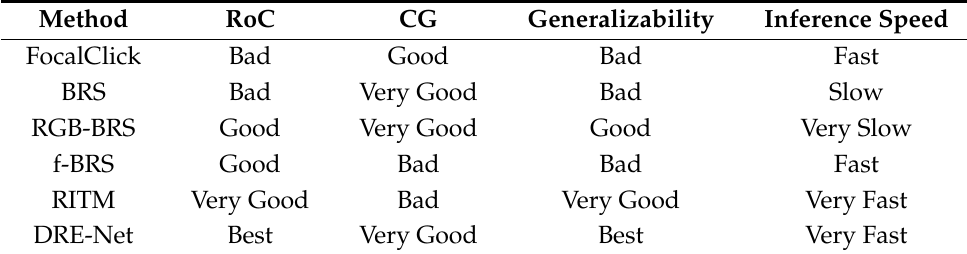
Table 5. Comprehensive comparison of the different